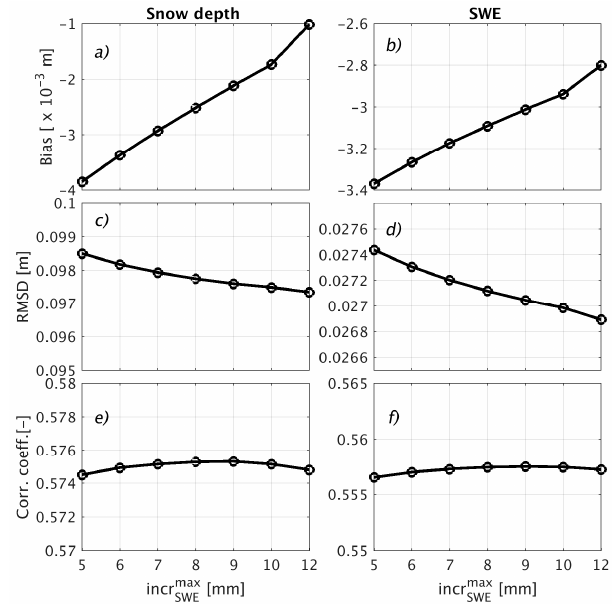
Figure 10. Optimization of the maximum SWE added ( incr Max ) to a catchment. Subplots ( a , c , e ) are, respectively, the bias, RMSD, and the correlation coefficient of the DA snow depth versus CMC snow depth. Supblots ( b , d , f ) are, respectively, the bias, the RMSD, and the correlation coefficient of the DA SWE versus CMC SWE using the snow density parameterization of [71].